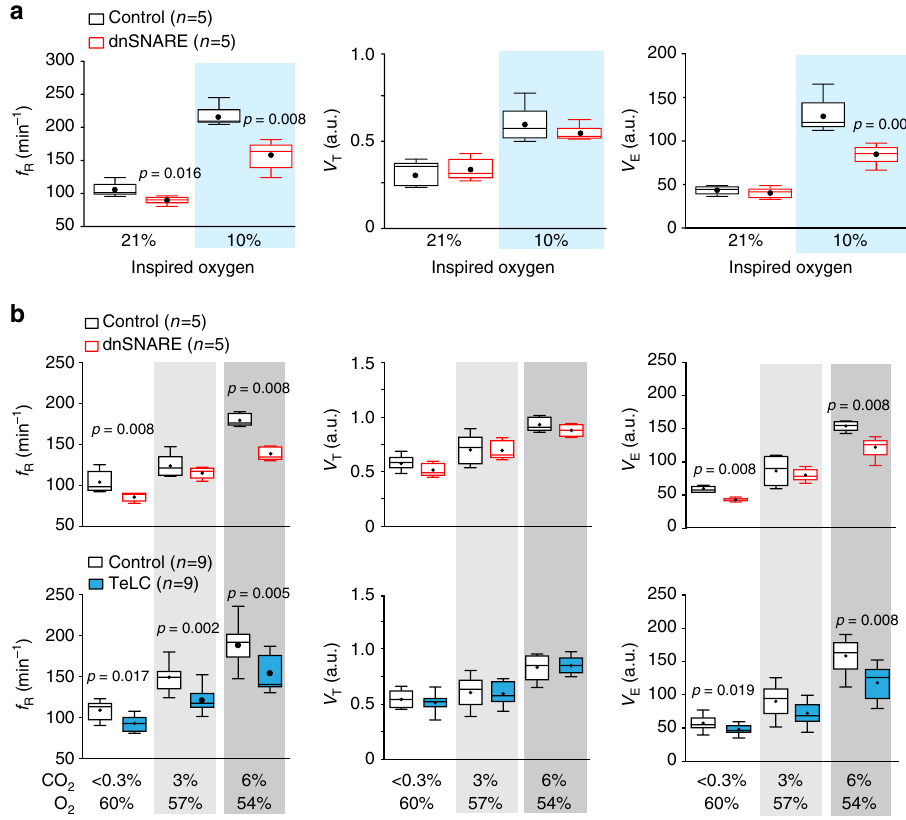
Fig. 4 Astrocyte signaling within the preBötC contributes to the development of the respiratory responses to systemic hypoxia and hypercapnia. a Summary data illustrating the effect of dnSNARE expression in preBötC astrocytes on hypoxia-induced increases in the respiratory frequency ( f R ), tidal volume ( V T ), and minute ventilation ( V E ) in conscious rats. b Group data illustrating the effect of dnSNARE or TeLC expression in preBötC astrocytes on CO 2 -induced increases in ƒ R , V T , and V E in conscious rats. The signi fi cant reduction in V E during systemic hypoxia or hypercapnia in rats transduced to express dnSNARE or TeLC in preBötC astrocytes is attributable to the smaller increases in ƒ R without signi fi cant effects of either transgene on V T . Number of animals in each experimental group is indicated in parentheses. p values — Mann – Whitney U rank test. Data sets without p values indicated are not